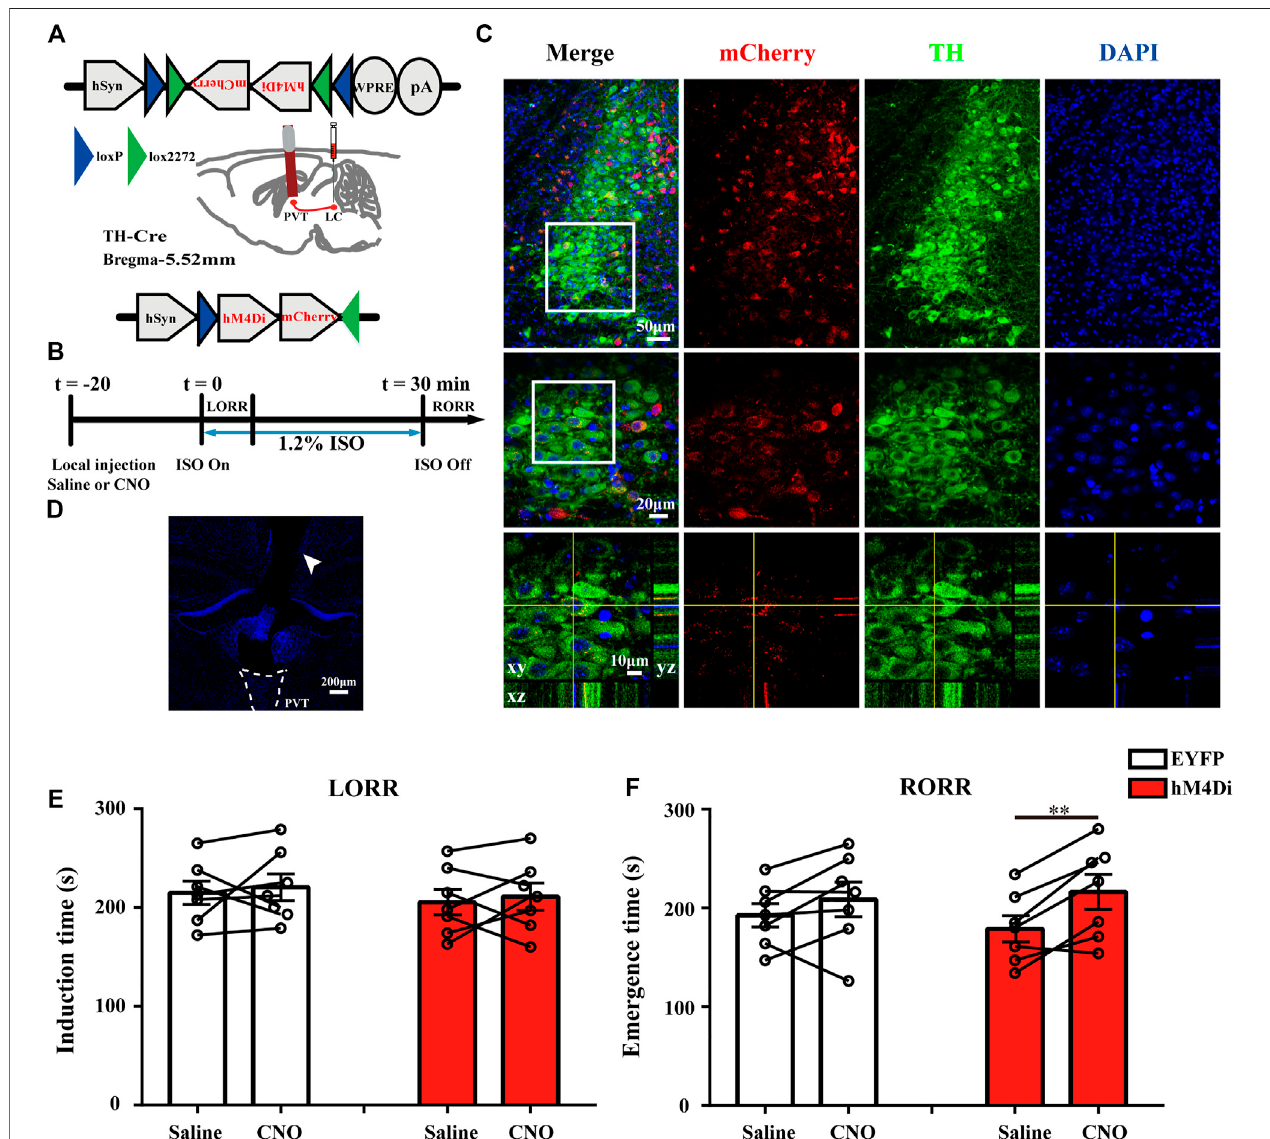
FIGURE 6 | Chemogenetic inhibitionofTH: LC-PVT terminals delaysemergence fromiso fl urane anesthesia. (A) Schematic ofbilateral LCinjection and guide cannula implantation. (B) Experimental protocol for chemogenetic inhibition of LC TH terminals in the PVT during 1.2% iso fl urane anesthesia. (C) Speci fi c expression of hM4Di- mCherry(red)inLCTH(green)neurons.Insetswereampli fi edinbelow. (D) DAPIstainedcoronalbrainsliceshowingthetrackoftheguidecannula(whitearrowhead)above thePVT. (E) InhibitionofTH:LC-PVTterminalsshowednosigni fi cantchangesofinductiontimeinhM4Dimice( n (cid:1) 7ineachgroup,two-tailedpairedt-test). (F) Inhibition of TH:LC-PVT terminals signi fi cantly delayed emergence time in hM4Di mice ( n (cid:1) 7 in each group, two-tailed paired t-test, ** p < 0.01). Data shown as means ± SEM.